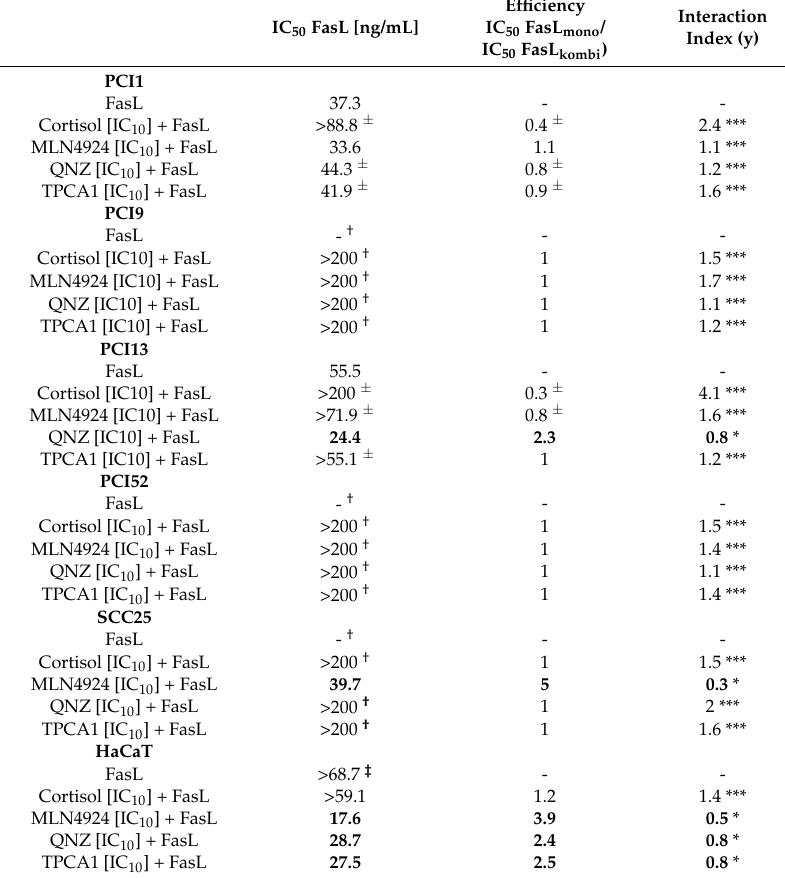
Table 3. Efficiency quotient and interaction index ( y ) of combination therapy with NF κ B inhibitors and the death ligand FasL. HNSCC cell lines (1 × 10 4 /well) were incubated with the indicated concentrations of FasL in combination with the cell line-specific constant IC 10 of the indicated NF κ B inhibitor ( n = 3) as shown in Table 1. The values of the IC 50 FasL mono and IC 50 FasL combi , efficiency quotient and interaction index were determined as described in the material and methods section. The interaction index, as described by Tallarida, for determining synergistic effects is annotated as follows: * = superadditive (synergistic, resp.), ** = additive, *** = antagonistic. Samples with pro-apoptotic sensitisation of the cells are highlighted in bold. Cell lines for which no IC 50 could be determined due to FasL resistance (PCI9, PCI52 and SCC25) as well as cell lines that remained resistant (PCI9 and PCI52) are marked with † . Furthermore, samples for which a complete IC 50 saturation curve was not formed for FasL are designated with ‡ . Samples for which the additional application of NF κ B pathway inhibitors led to a decrease in the FasL effect are marked with ±